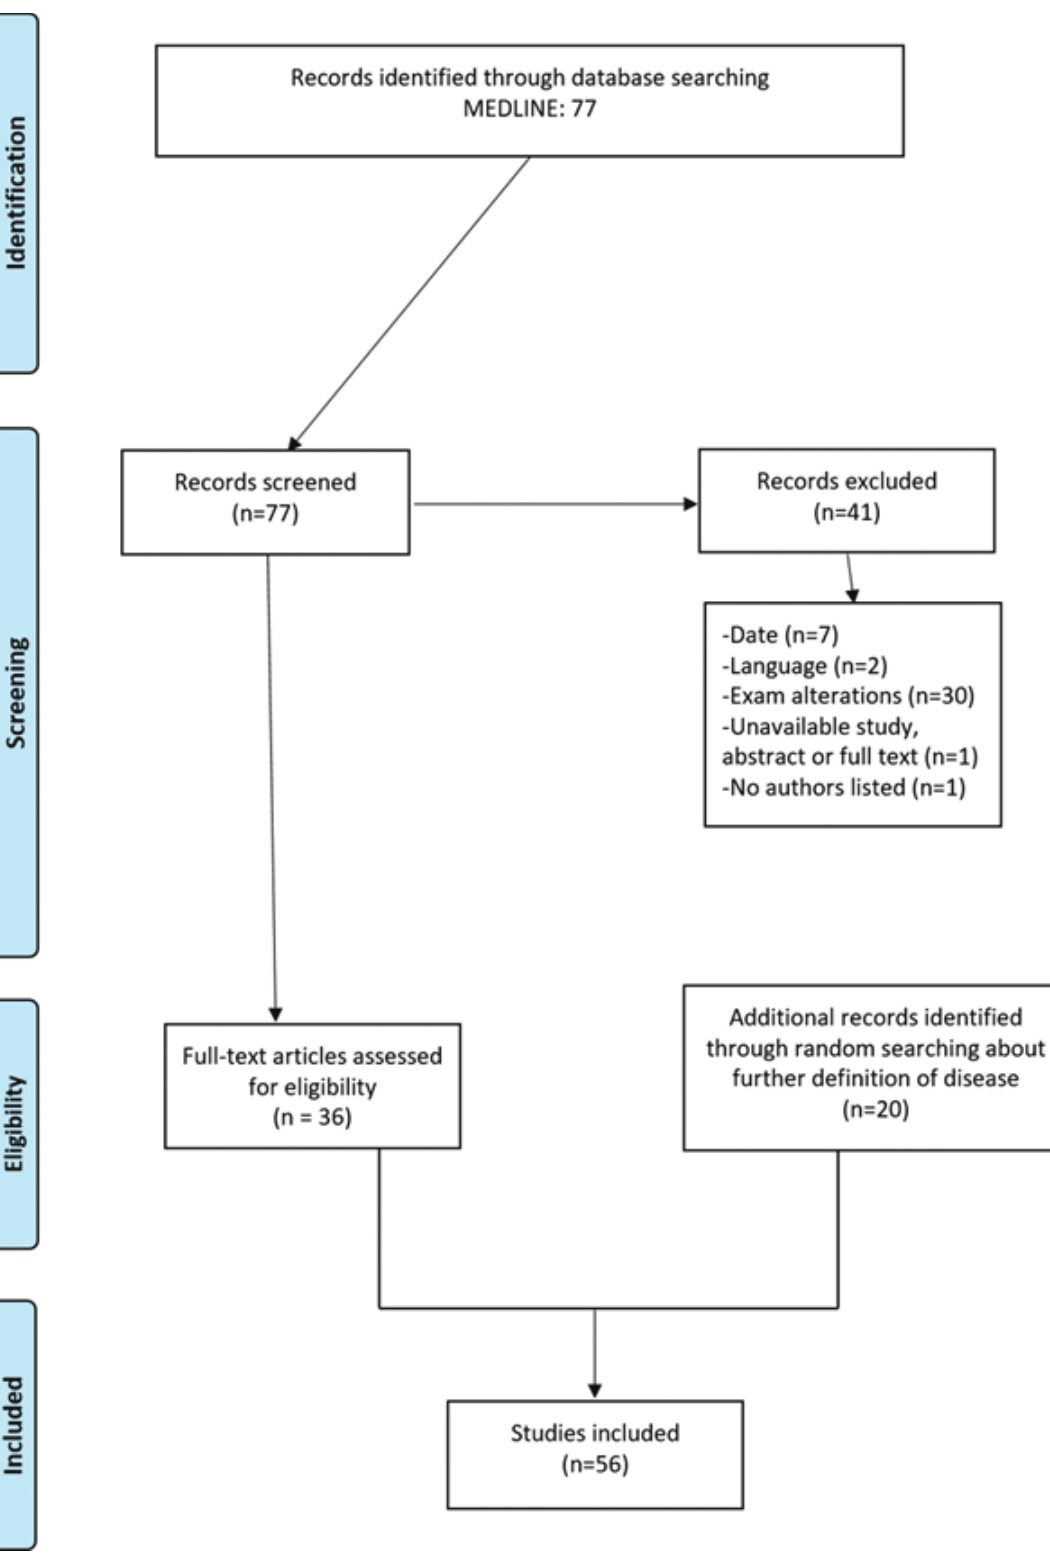
Figure 1. Inclusion and exclusion